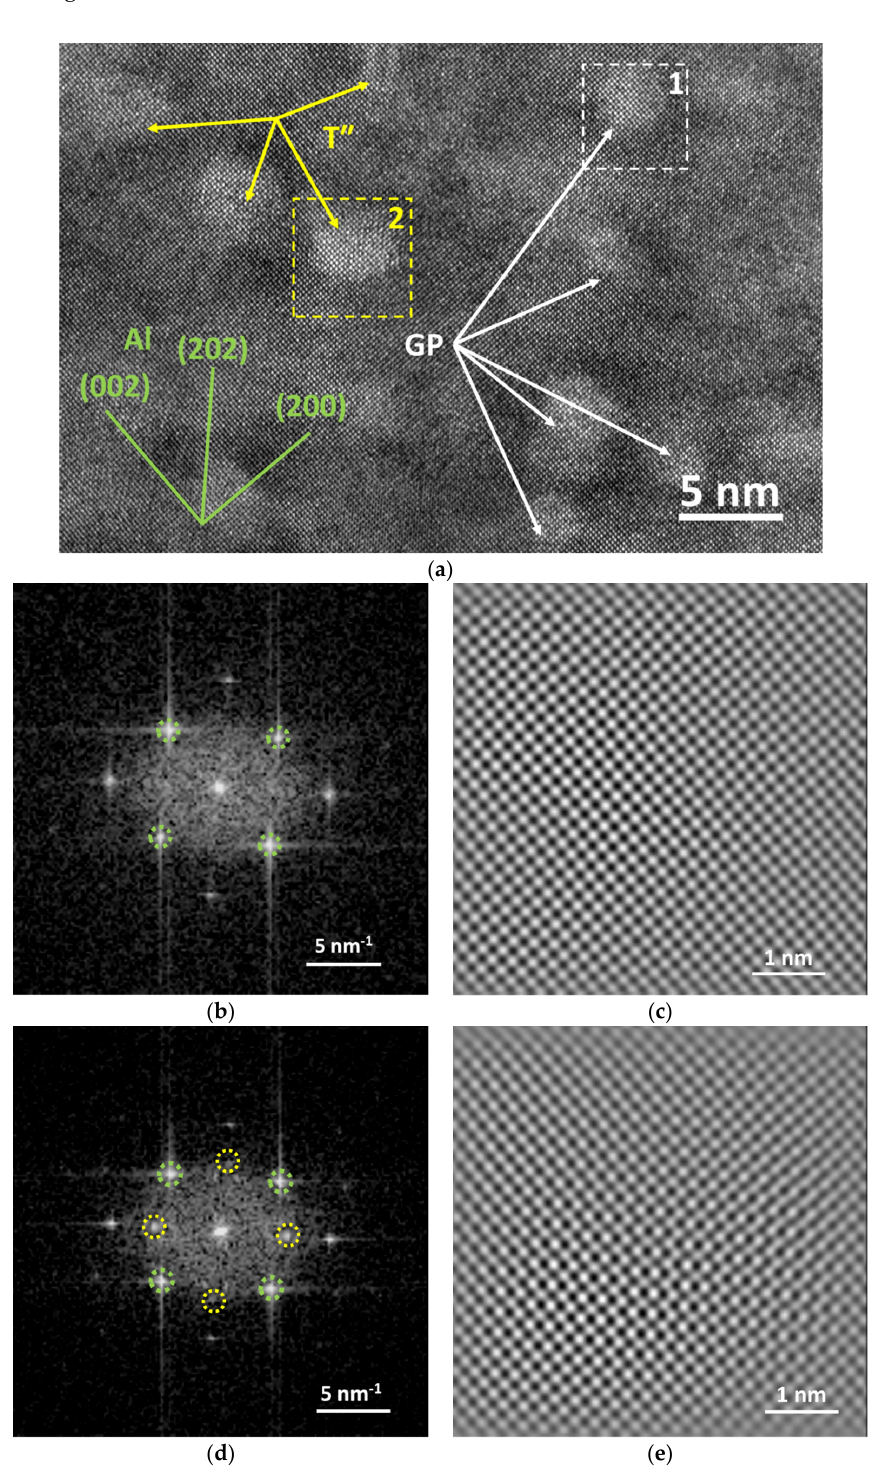
T” phase [8]. The two types of precipitates are marked with white and yellow arrows, respectively, in Figure 6a, while the lattice planes of the aluminum alloy matrix are marked with green bars and indices.